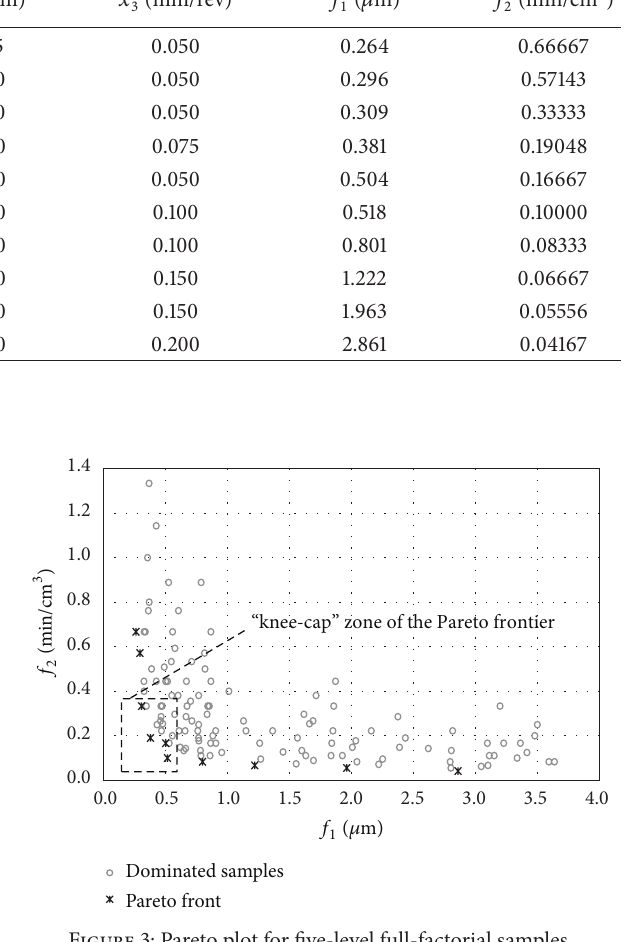
Table 3: Listing of undominated samples from full-factorial matrix.